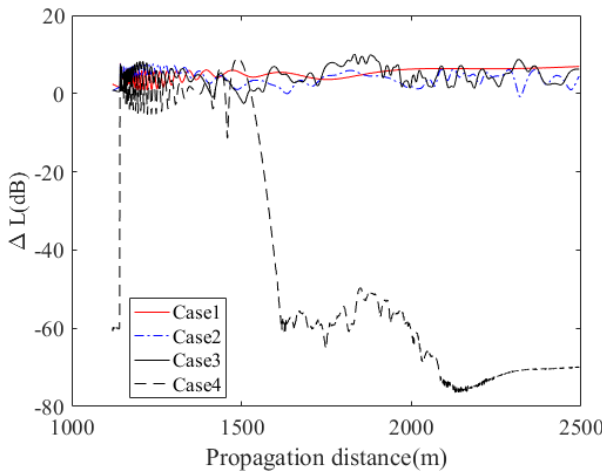
Figure 18. The RSPL at 2 m height extracted from four cases of Figure 16.